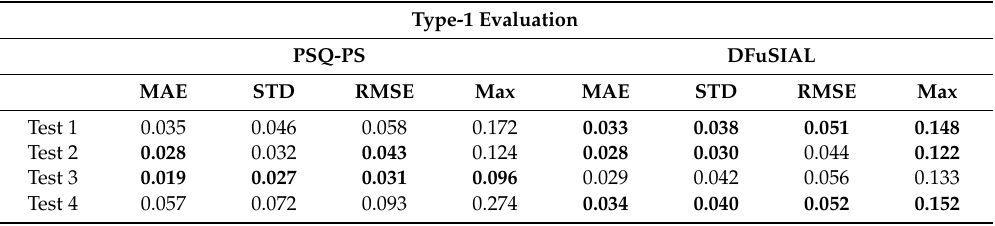
Table 2. Type-1 evaluation of fraction values, obtained in Experiment 1 (Tests 1–4) by PSQ-PS and the proposed fusion method DFuSIAL, with respect to the obtained fractions, in HSR by